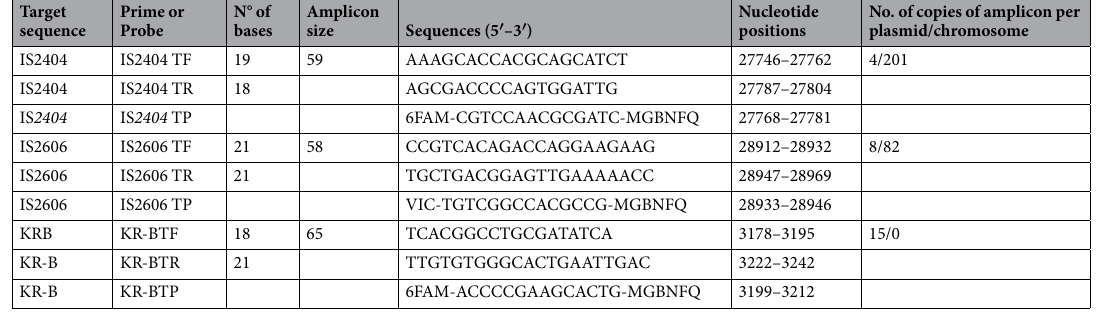
Table 2. Primers and probes designed for real-time PCR detection of M. ulcerans by targeting IS2404, IS 2606 , and KR-B